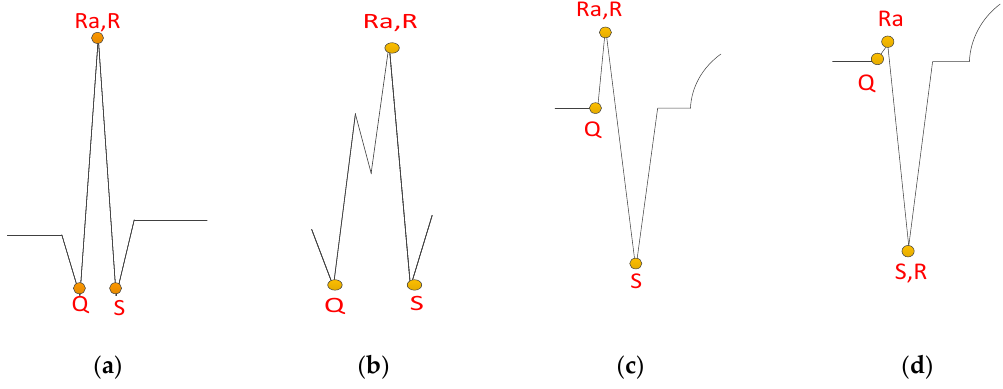
Figure 11. QRS waveform templates of four desired recognition features: ( a ) normal QRS waveform; ( b ) fork-like crests; ( c ) deep S wave with small R wave; ( d ) deep S wave with tiny or hidden R wave.